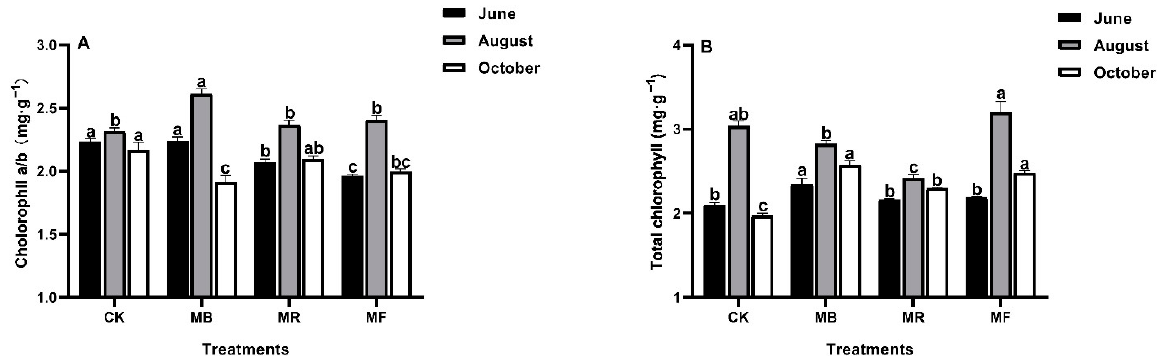
Figure 2. The effect of mulch treatments on leaf chlorophyll contents, where MB: bamboo leaves mulch, MR: rice husks mulch, MF: organic fertilizers mulch, and CK: control. ( A ) Chlorophyll a/b (Chl a/b); ( B ) Total chlorophyll (Tc). Various letters on each bar show significant differences ( P < 0.05) with vertical bars as standard errors ( n = 4).